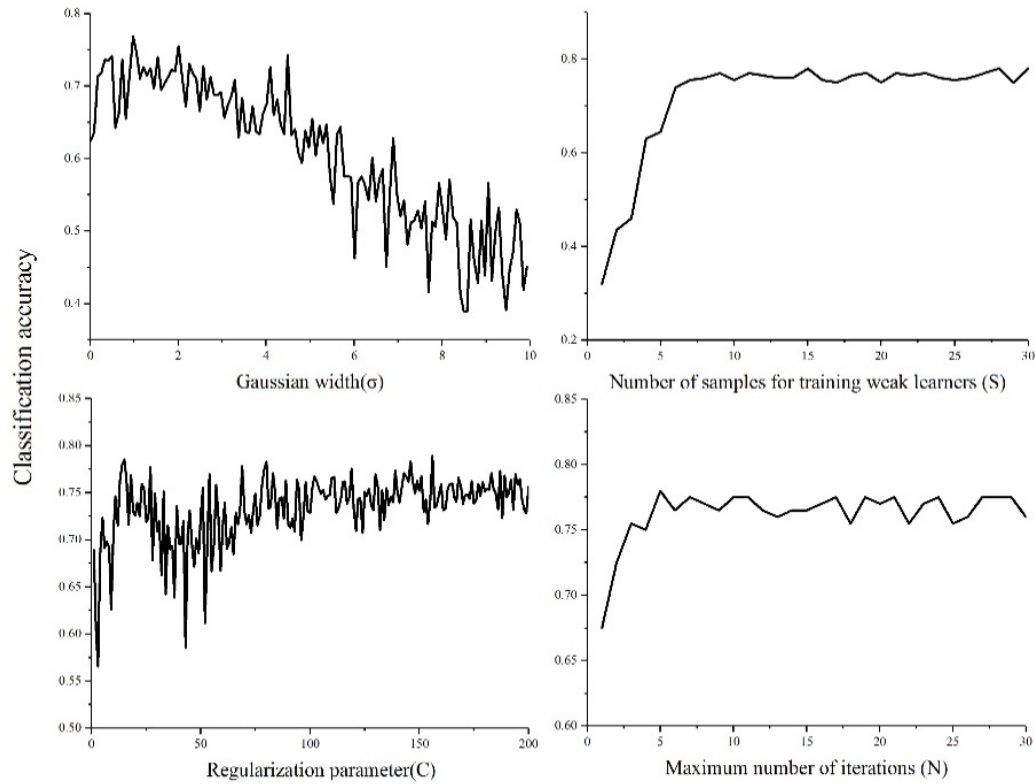
Figure 4. The performance of OpTrAdaBoost with different values of  , C, N, and S for the